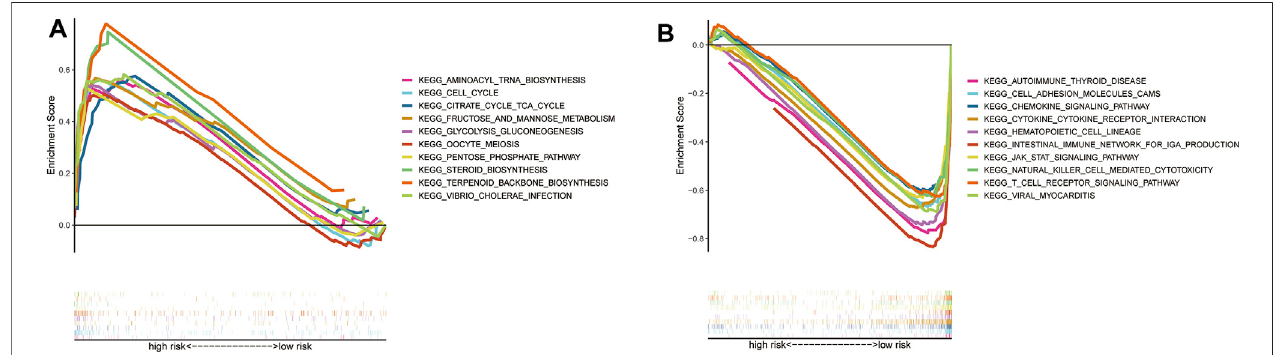
FIGURE 6 | GSEA analysis results (A) . GSEA validated the top 10 of enhanced activity in high-risk group (B) . GSEA validated the top 10 of the downgrade in low- risk group (C)